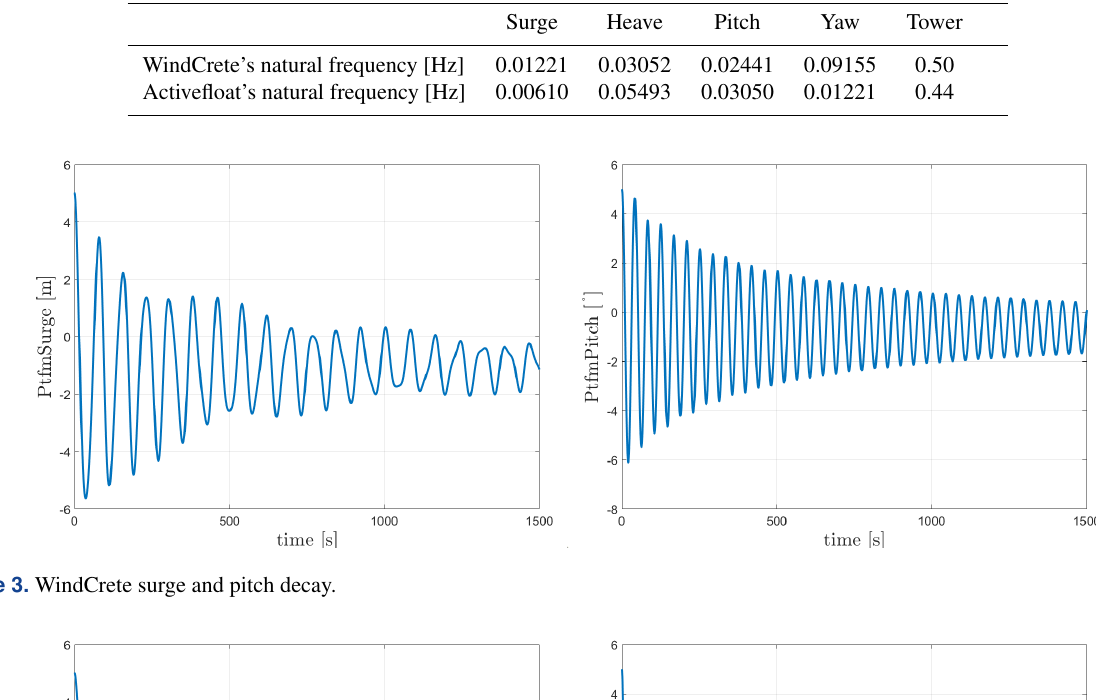
Table 10. Floaters’ and towers’ natural frequencies.